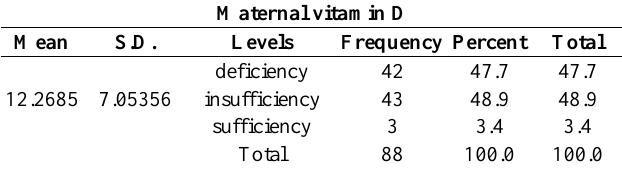
Table 2: Maternal Vitamin D mean, standard deviation and levels. Maternal vitamin D